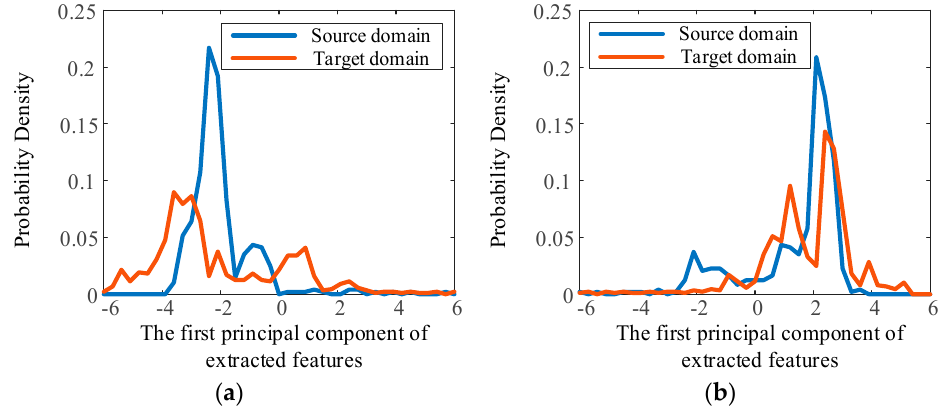
Figure 8. Probability density distribution of the first principal component of extracted features. Source domain is bearing3-1, target domain is bearing2-1. ( a ) Without transfer learning. ( b ) With transfer learning.